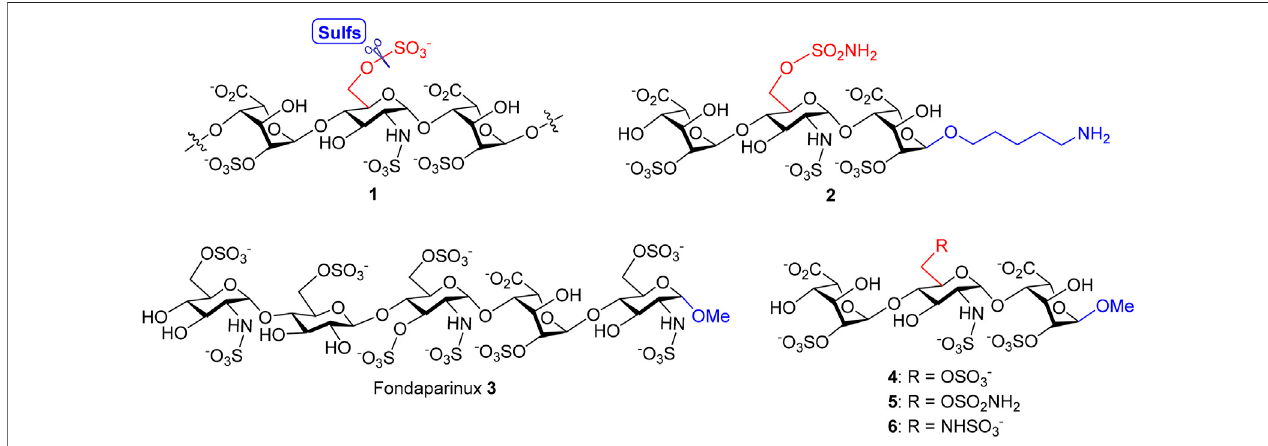
FIGURE1| StructuresofSulf-1 ’ strisaccharideunit 1 andinhibitor 2 witha5-amino-1- n -pentyllinker,theanticoagulantFondaparinux 3 ,andtheproposedSulf-1 ’ s substrate 4 and inhibitors of the 6 ′ - O -sulfonamide 5 and the 6 ′ - N -sulfate 6 with the methyl group at 1-O.